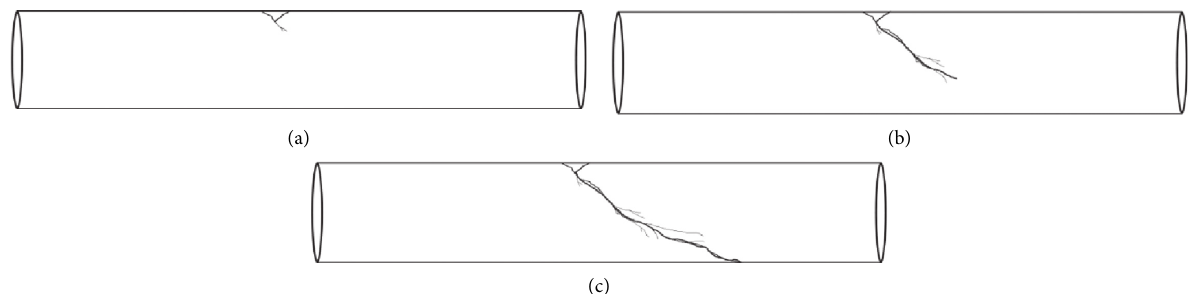
Figure 13: The fracture path profile of S-6. (a) Stage I. (b) Stage II. (c) Stage